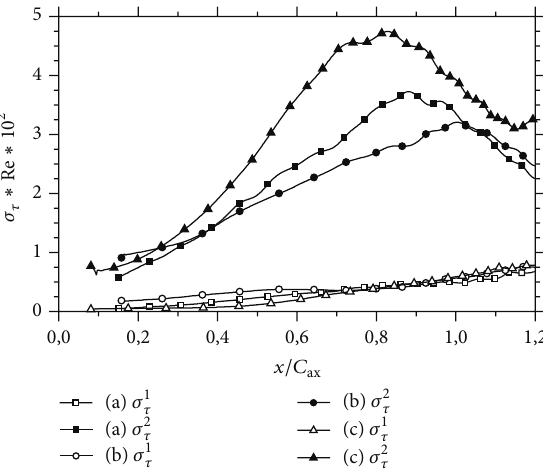
Figure 7: Time averaged magnitude of the stress tensor eigenvalue along line 𝑃 versus the axial coordinate in the blade vane: (a) LES: Re = 5.18 × 10 4 , (b) DNS: Re = 5.18 × 10 4 , and (c) LES: Re = 1.48 × 10 5